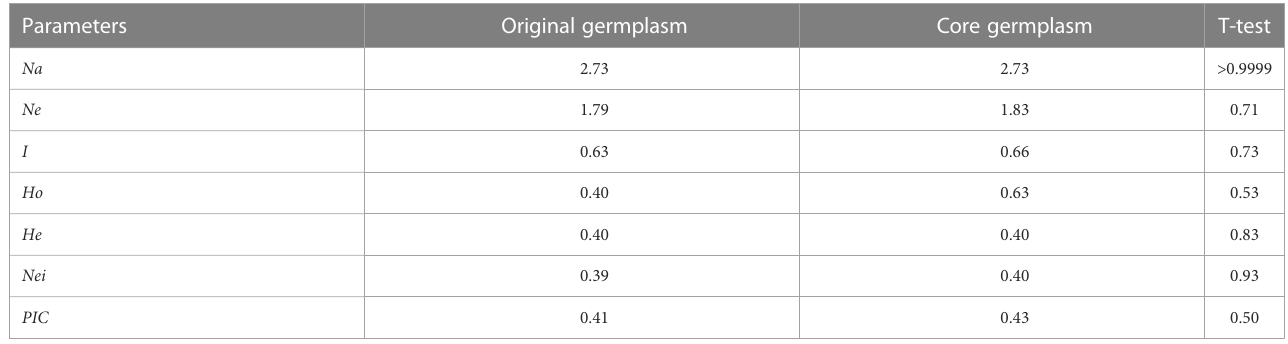
TABLE 3 Comparison of genetic parameters between core collection and original germplasm GraphPad Prism 8.4.3 (GraphPad Software Inc., USA: http:// www.graphpad.com/) was used to statistical analysis of P